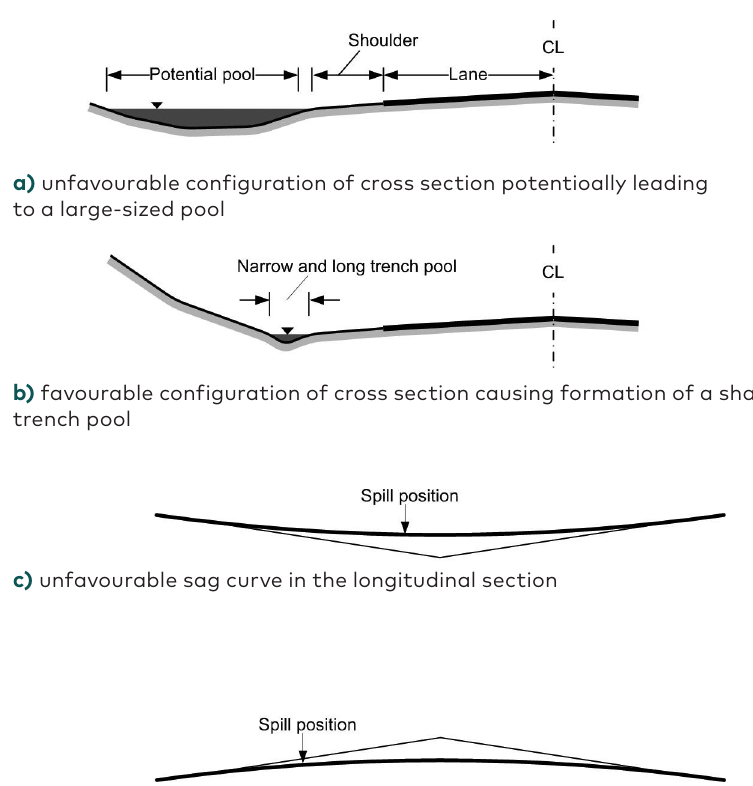
Figure 3. Transverse and vertical alignments of road causing escalation or de-escalation of spill